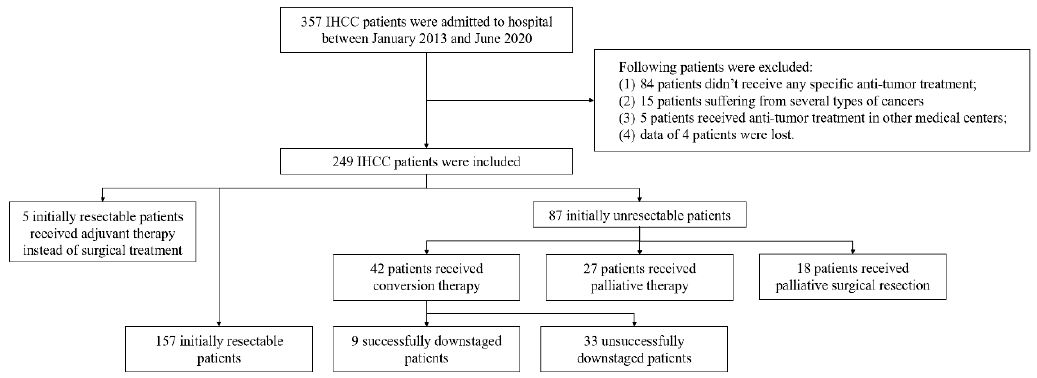
Figure 1. Flow chart of this study.